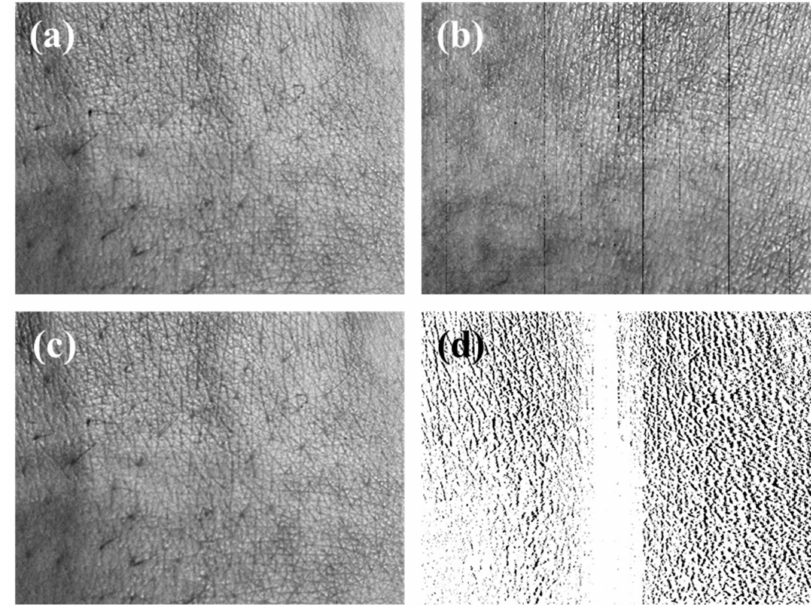
Figure 10. The distortion correction results of the mobile skin image acquiring the working distance of 60 mm. ( a ) The distorted original skin image, ( b ) the corrected skin image, ( c ) the interpolation skin image, ( d ) the subtraction image from the distorted image and the interpolation image.